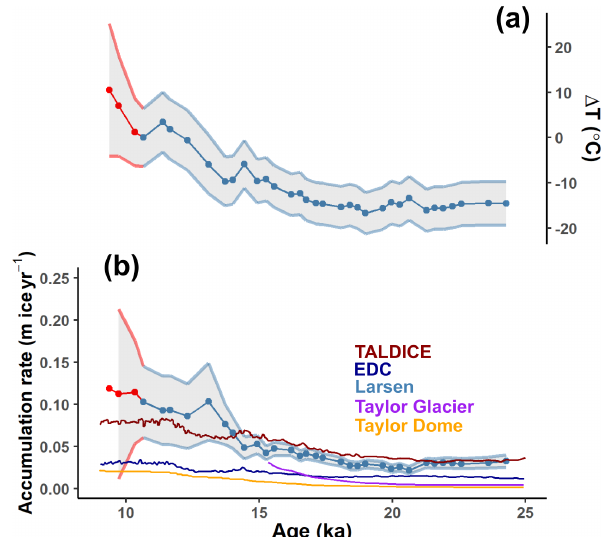
Figure 10. Reconstructed surface temperature and accumulation rate over the Last Glacial Termination (Termination I). Accumu- lation rates of TALDICE and EDC are from Veres et al. (2013). Accumulation rates of Taylor Dome and Taylor Glacier are from Baggenstos et al. (2018). The three youngest values of Larsen blue ice are rejected (red line) due to the large uncertainty in the (cid:49) age that translates into the possibility of negative accumulation rates and an unexpected 10.5 ◦ C increase in ∼ 1200 years. (cid:49)T is a value rel- ative to 10.6kyrBP; 10.6kyrBP is the youngest time period avail- able. The uncertainty for (cid:49)T and the accumulation rate (1 σ ) was estimated through error